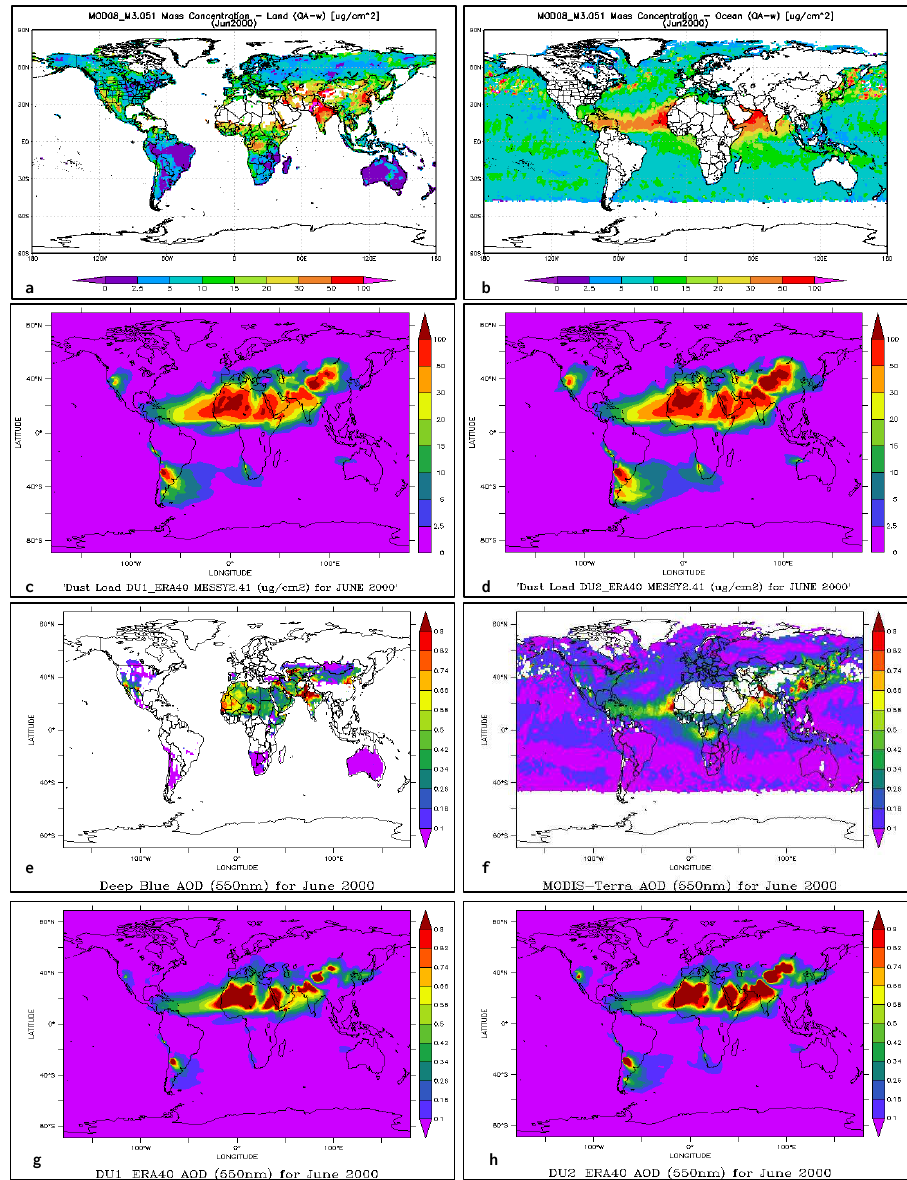
Fig. 14. Column aerosol mass concentration (µgcm − 2 ) and aerosol optical depth from the MODIS-Terra (v5.1) satellite ( a, b and e, f ) and from the model simulations using the DU1 ERA40 (c, g) and DU2 ERA40 (d, h) simulations for June